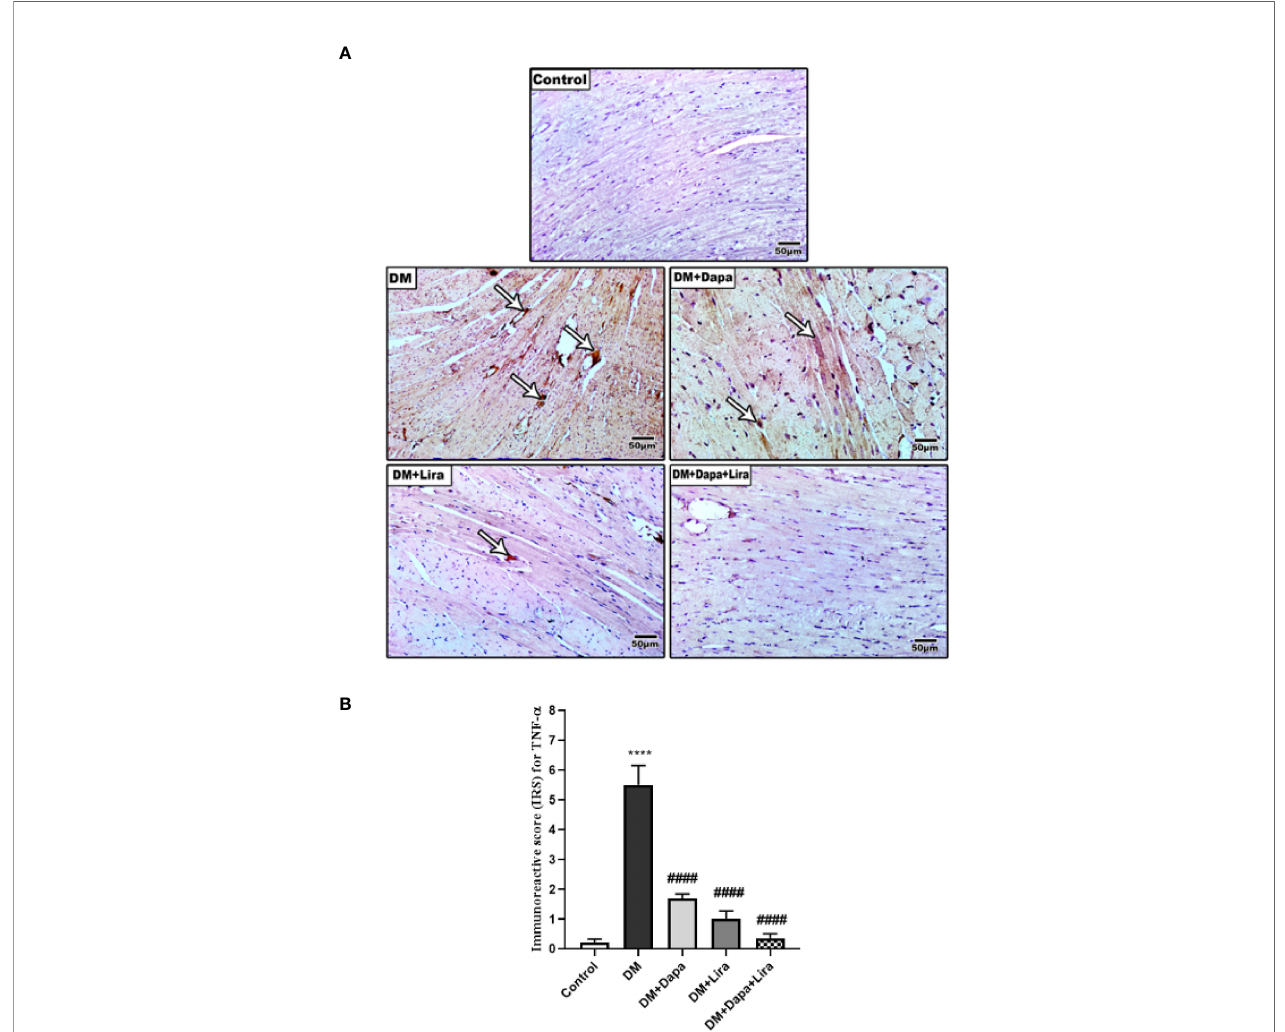
FIGURE 7 | (A) Representative photomicrographs of TNF- a immuno-stained cardiac sections from different experimental groups, ×200 bar 50. (B) A graph showing immunoreactive score for TNF- a cellular expression. Data are represented as mean ± SE, n = 6. **** signi fi cance in comparison with control group at p < 0.0001, #### signi fi cance in comparison with diabetic group at p < 0.0001. Dapa, dapagli fl ozin; Lira,